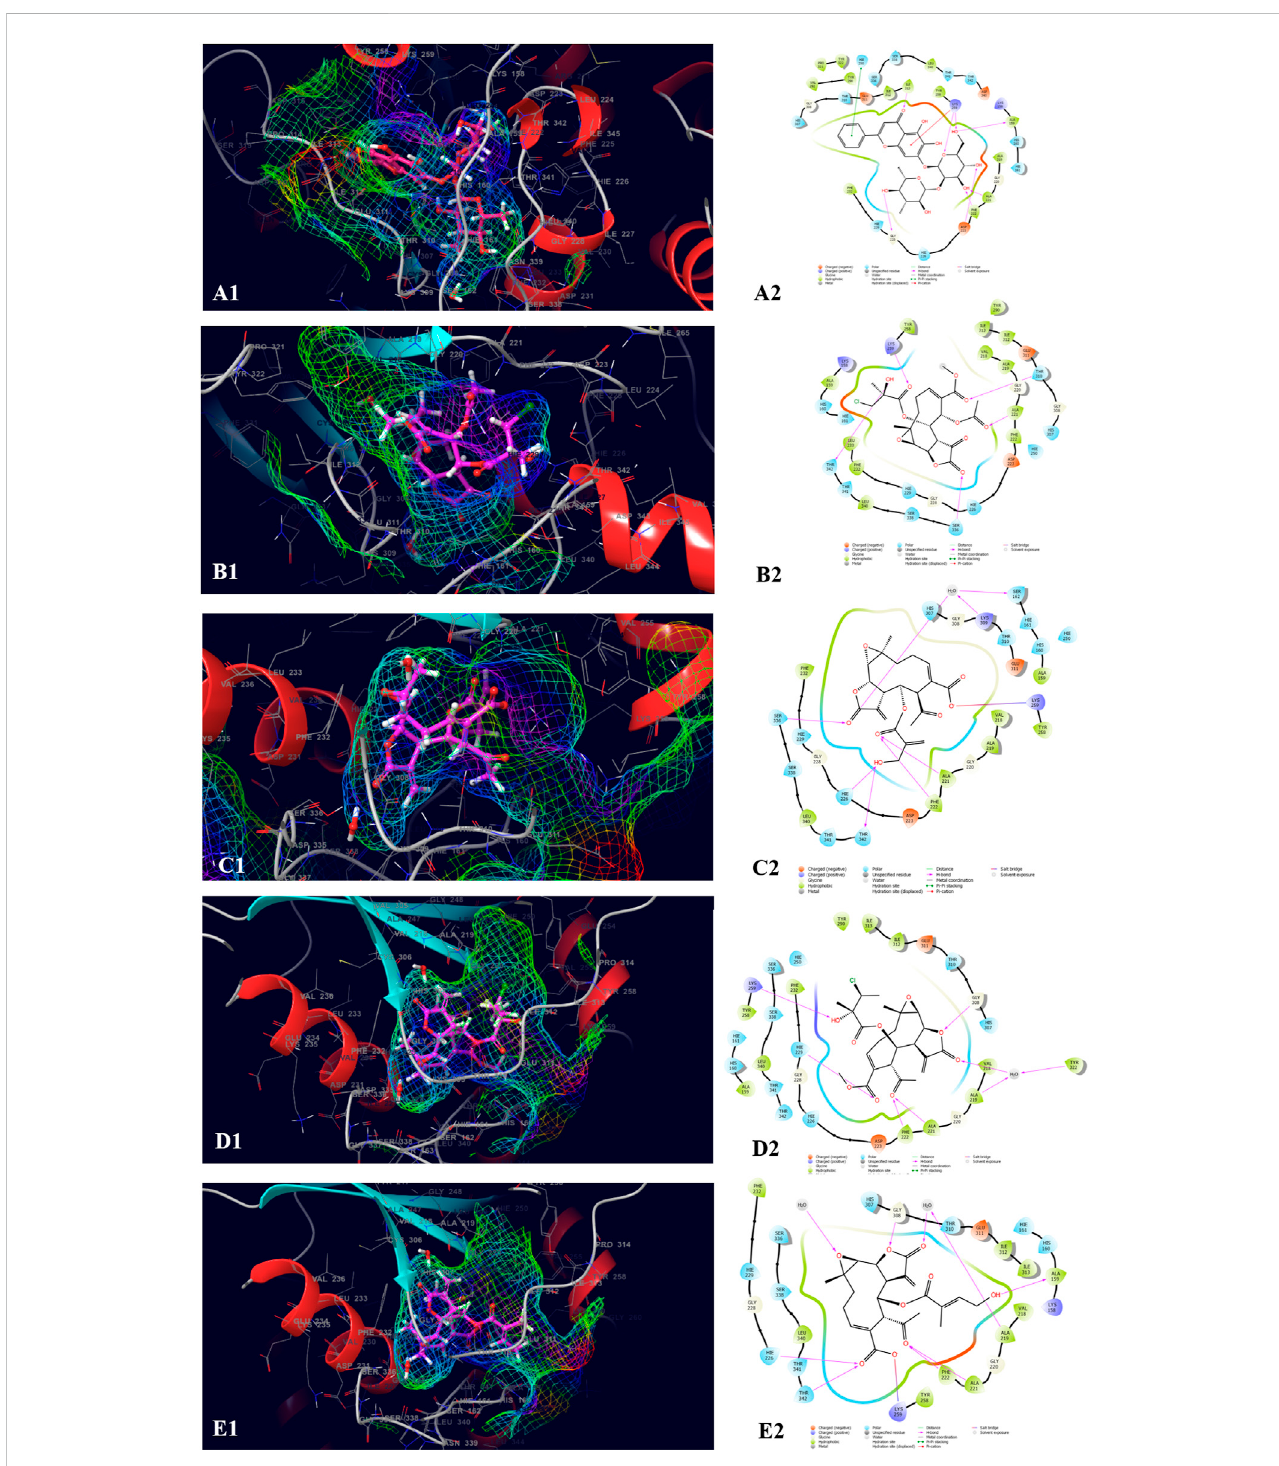
FIGURE 4 MoleculardockinginteractionsofmetabolitesinthebindingpocketofPDBID:3ELB.[3Dand2DrepresentationofBaicalein7-O-diglucoside (A1,A2) ,8- Deepoxyangeloyl-8-2-hydroxy-3-chloro- isobutyroyl-enhydrin (B1,B2) , 8-Desacylenhydrin-4-hydroxymethacrylate (C1,C2) , 8-Deepoxyangeloyl- 8- chloro- 2-hydroxy-2-methylbutyroylenhydrin (D1,D2) and 8-Desacyl enhydrin-4-hydroxytiglate (E1,E2) in the binding pocket of (PDB ID: